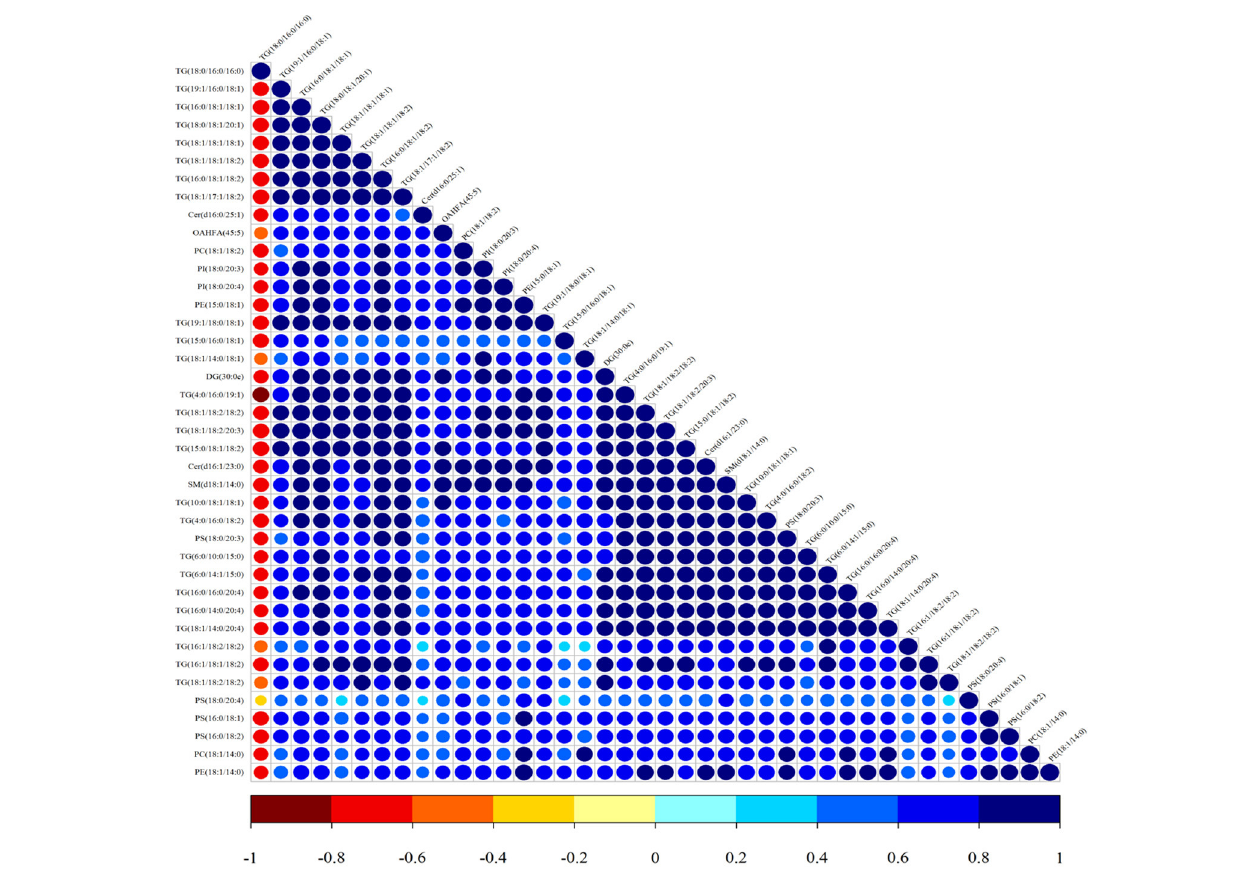
FIGURE 4 | Correlation analysis of lipid molecules in the CTR and EUL groups. Map illustrating the correlations among lipid species differing significantly between EUL and CTR groups. The color of the points represents the degree of correlation, varying from − 1 to 1, from jujube red to blue,